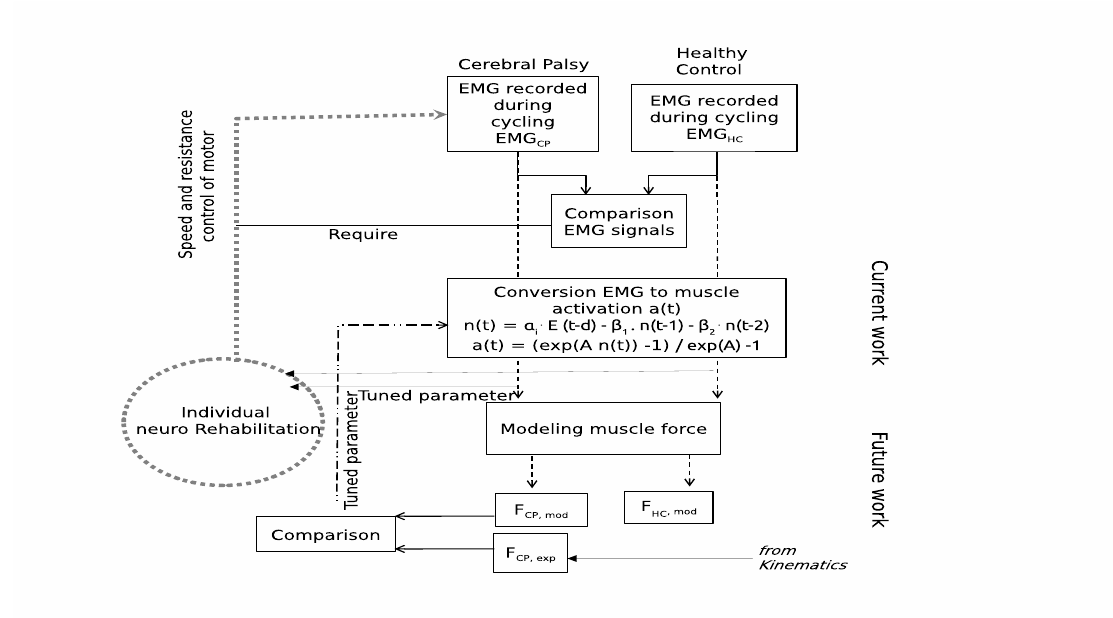
Figure 1. Schematic representation of steps followed in the present work and to be followed in future work. EMG: